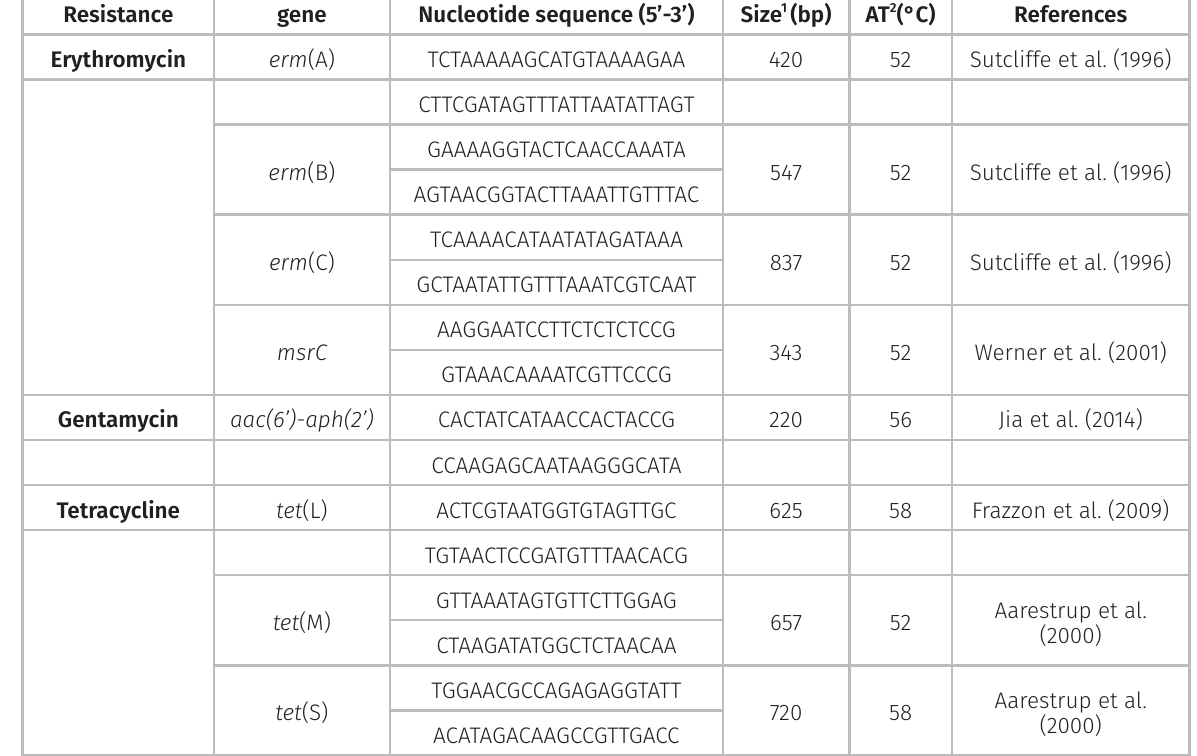
Table II. Primers used in the PCR reactions carried out for detection of resistance genes. Resistance gene